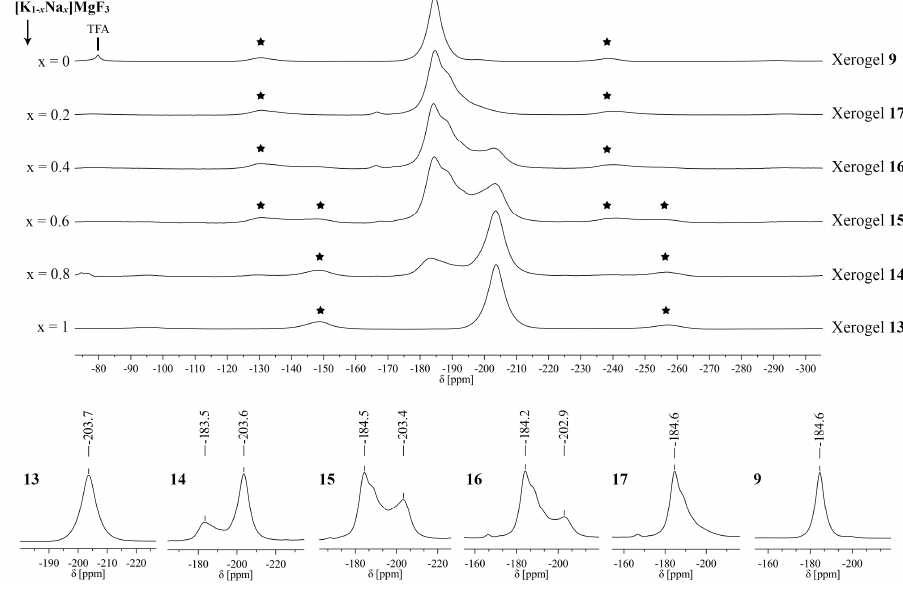
Figure 6. 19 F MAS NMR of xerogels 9 , 13 – 17 , star: spinning side band, υ rot = 20 kHz.